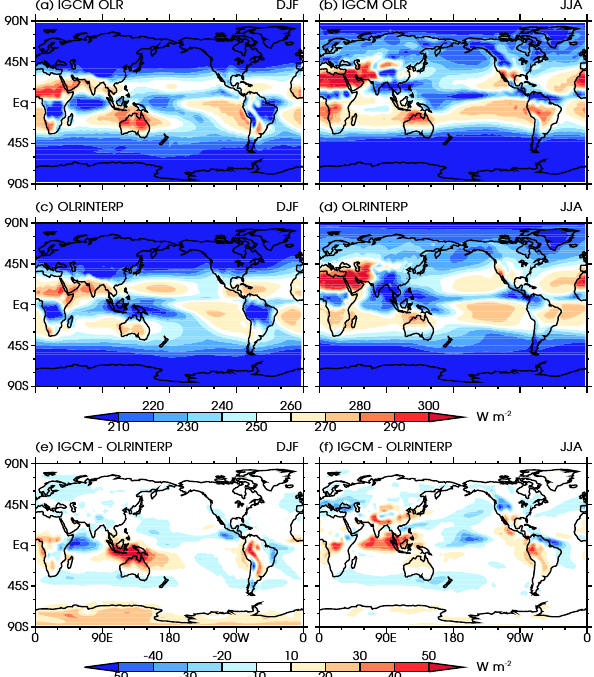
Figure 6. Outgoing long-wave radiation (OLR; Wm − 2 ) in IGCM4 (a, b) , interpolated OLR data set (c, d) and difference be- tween IGCM4 and interpolated OLR data set (Liebmann and Smith, 1996) (e, f) . In all cases the left-hand panels display results for the DJF season, and the right-hand panels display results for JJA sea- son. For the interpolated OLR data set a mean over the years 1979– 2011 is taken. Figure 7. Zonally averaged temperature (K) in ERA (a, b) , differ-